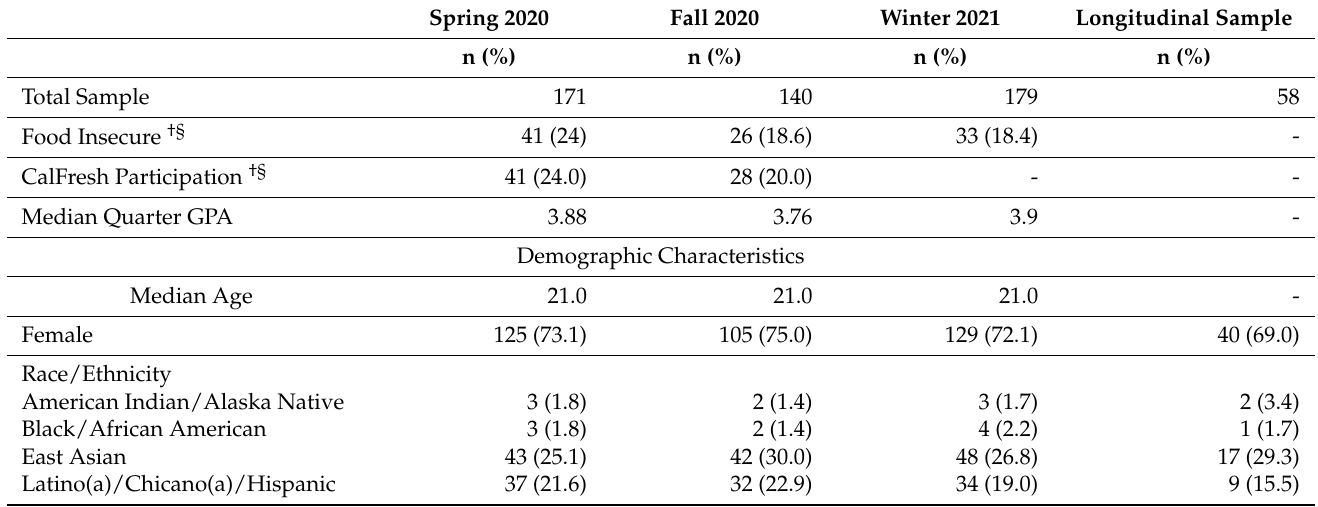
Table 1. Food Security, CalFresh Participation, and Demographic Characteristics of Quarter Samples and Longitudinal